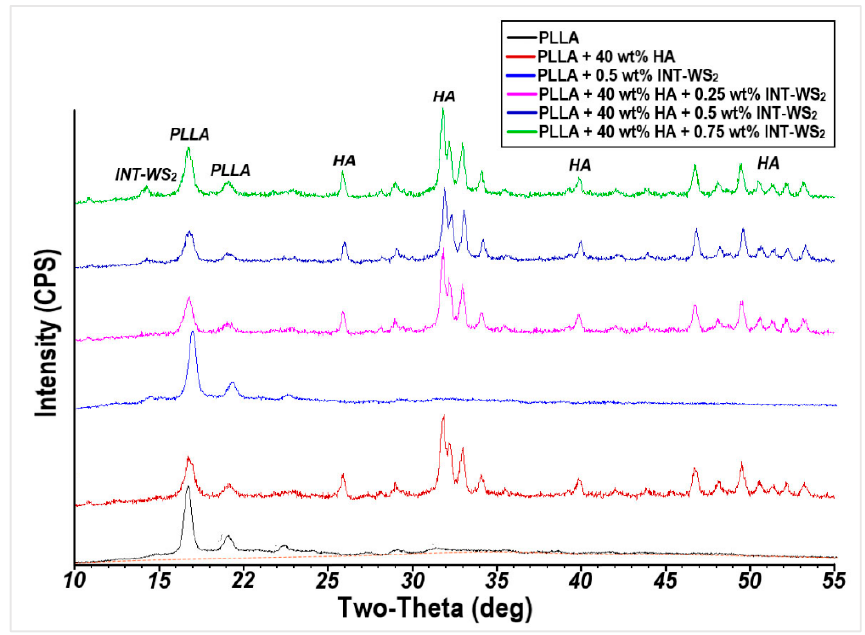
2 /PLLA nanocomposites.